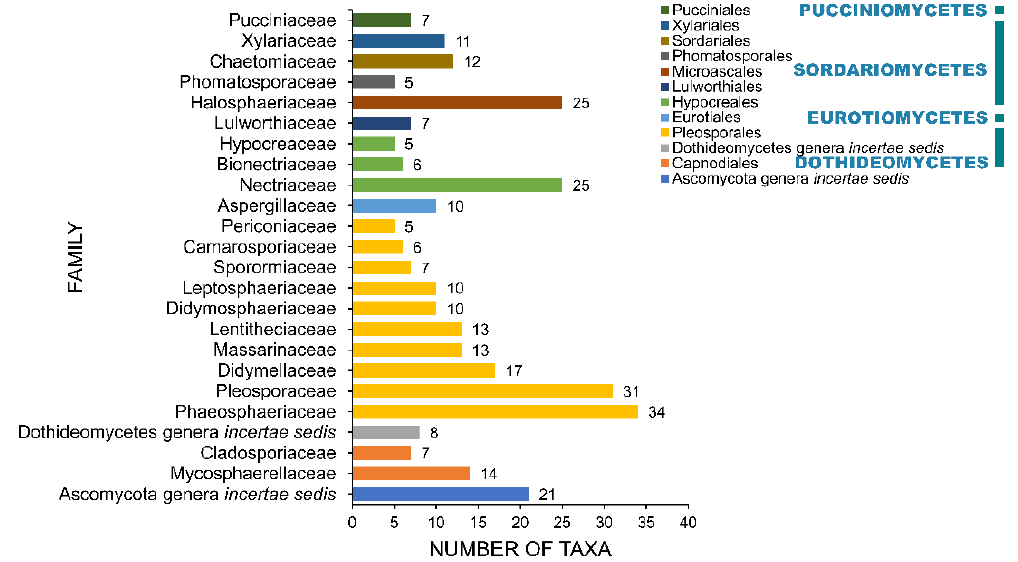
Figure 7. The distribution of salt marsh fungi among major fungal families.